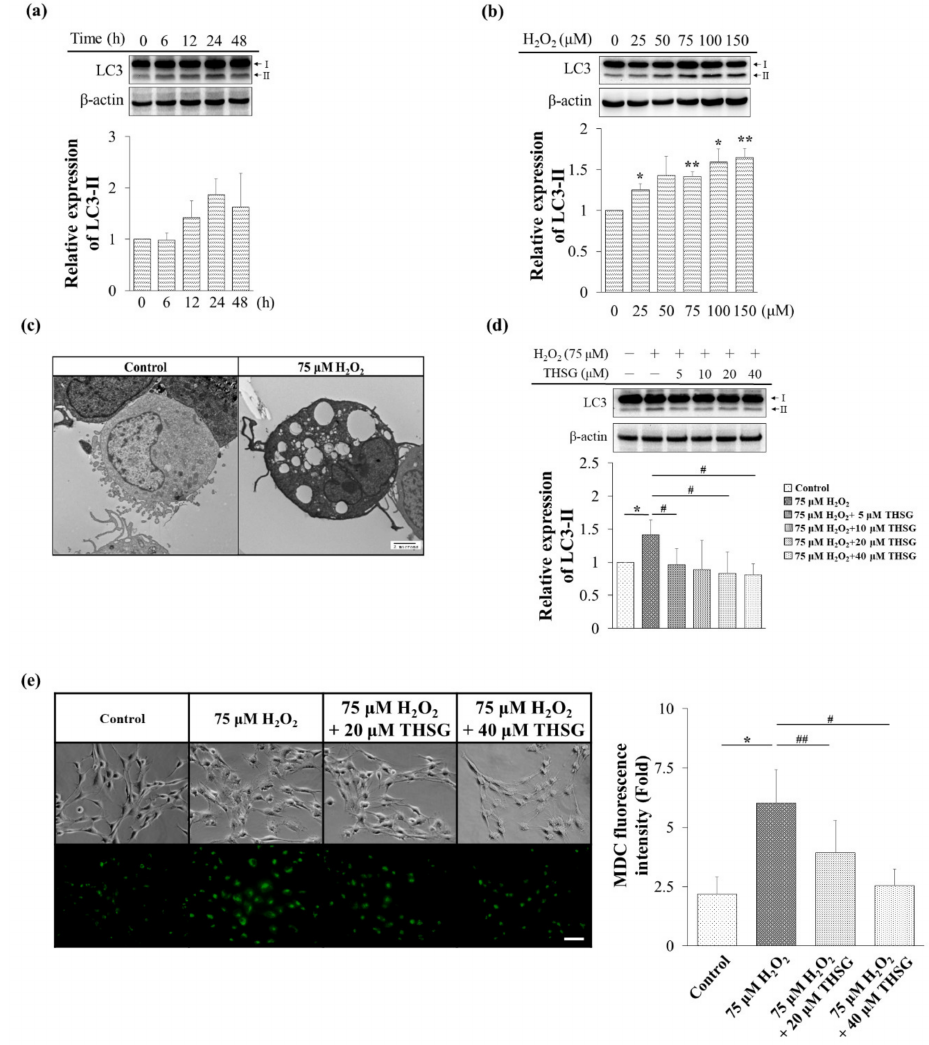
Figure 4. The THSG inhibits H 2 O 2 -induced autophagy in mouse cochlear UB / OC-2 cells. ( a ) The cells were treated with 75 µ M H 2 O 2 for 0–48 h, and the protein level of LC3 was measured by Western blotting. ( b ) The cells were treated with various concentrations of H 2 O 2 (0–150 µ M) for 24 h, and the protein level of LC3 was measured by Western blotting. ( c ) The cells were treated with 75 µ M H 2 O 2 for 18 h, and autophagy was observed by TEM. Black bar = 2 µ m. ( d ) The cells were pretreated with various concentrations of THSG (5–40 µ M) for 6 h and then stimulated with 75 µ M H 2 O 2 for 24 h, and the protein level of LC3 was measured by Western blotting. β -actin was used as the loading control. The results of protein expression were normalized to β -actin. ( e ) The cells were pretreated with 20 or 40 µ M THSG for 6 h and subsequently with 75 µ M H 2 O 2 for 24 h, and the fluorescence obtained using the MDC dye was detected using a fluorescence microscope. Scale bar = 40 µ m. Data are presented as the mean ± SD, n = 3. * p < 0.05 and ** p < 0.01 indicate significant differences from the control group. # p < 0.05 and ## p < 0.01 indicate significant differences from the H 2 O 2 -treated